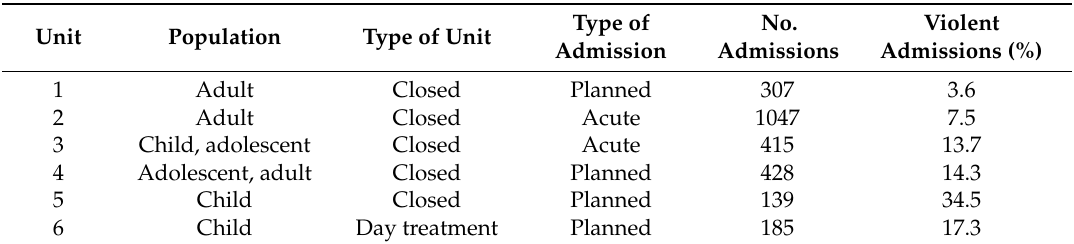
Table 1. Some descriptive statistics of the six inpatient units. An admission is classified as violent if at least one incident occurs between the second and 30th of